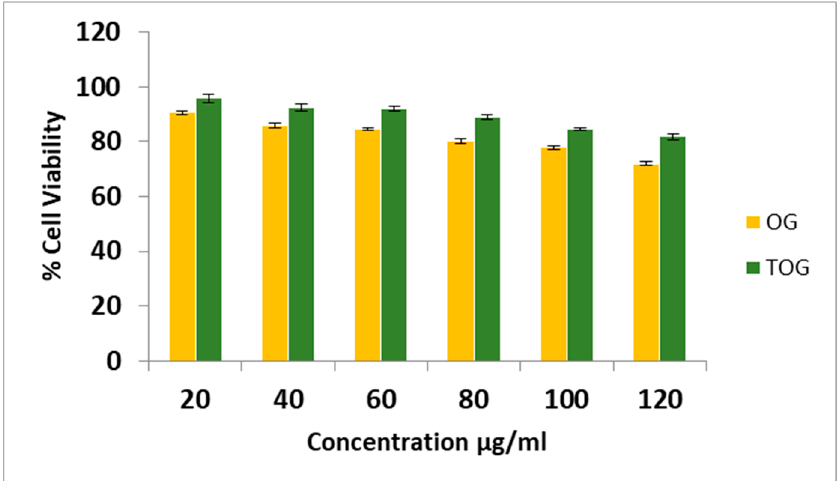
Figure 7. Cytotoxic study of OG and TOG at different concentrations on the HepG 2 cell line. Each point represents the mean ± SD.